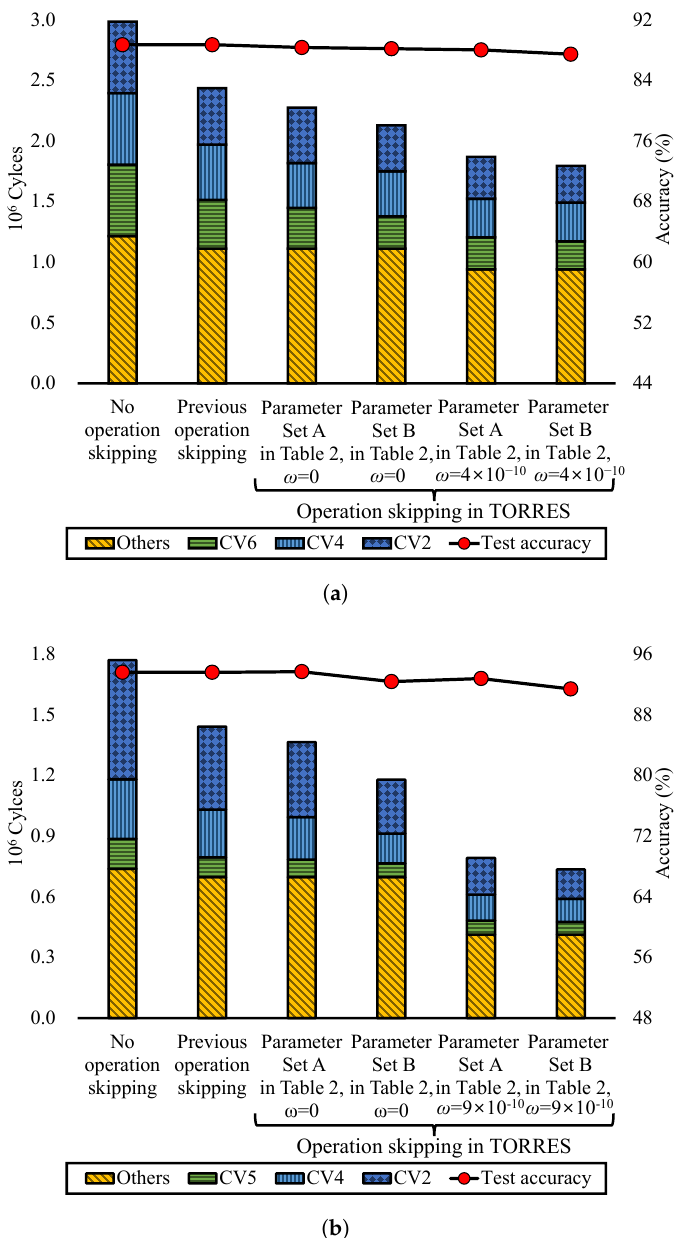
Figure 10. Cycle count and accuracy for the ( a ) CIFAR10 and ( b ) SVHN classification tasks. The second results in each figure have been obtained based on the previous operation skipping tech- niques